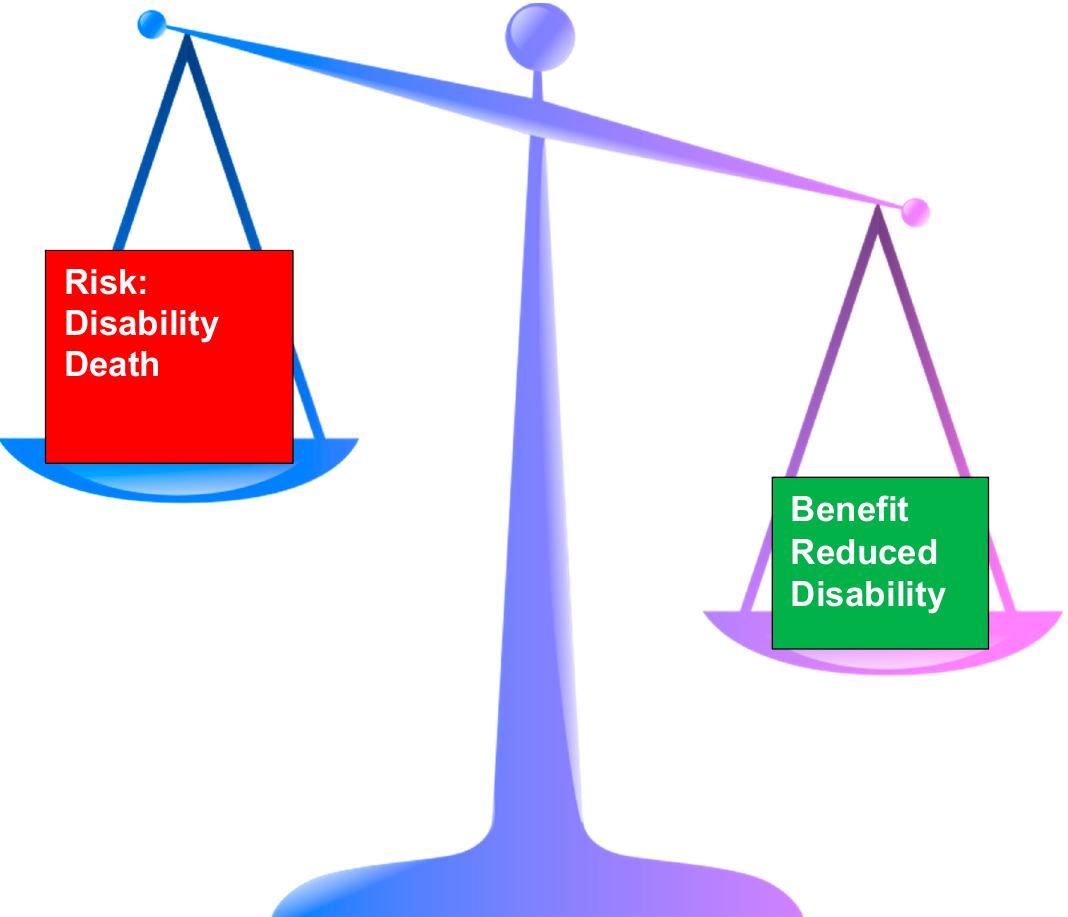
Figure 2. Schematic representation of risk vs. benefit in hyperacute stroke treatment in frail older adults.